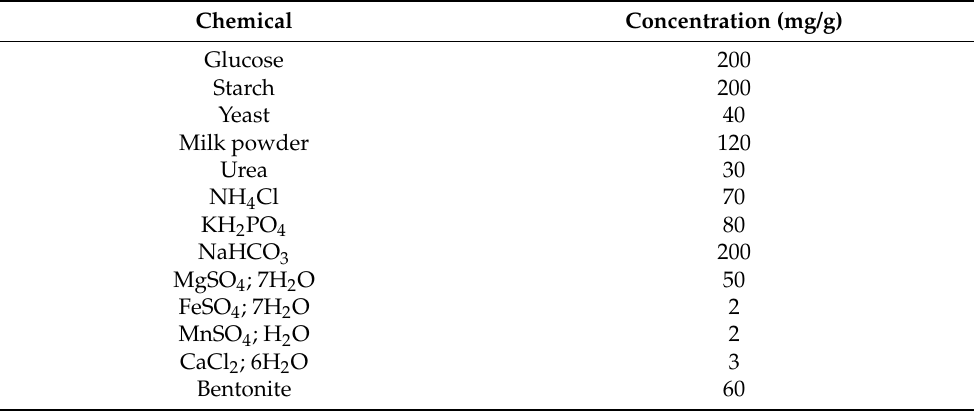
Table 1. Chemicals used to prepare the synthetic domestic wastewater composition.